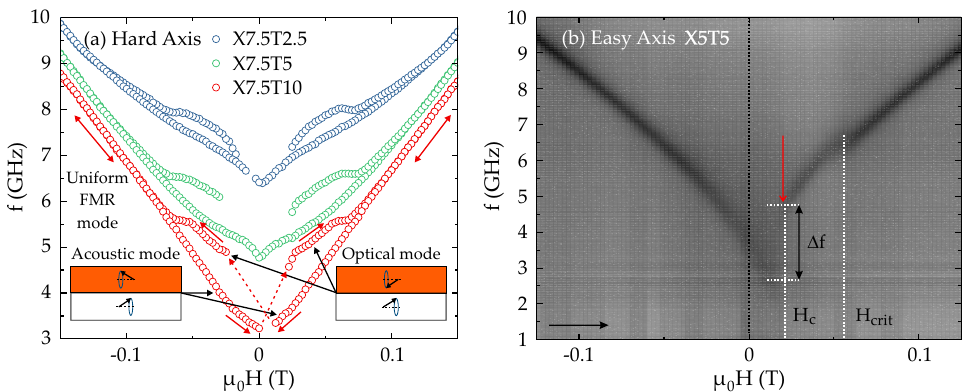
Figure 8. ( a ) Hard axis data of the X7.5 series. Red arrows indicate the field sweep directions with respect to the FMR line hysteresis around zero-field. The suggested modes corresponding to the different field regions of the f – H characteristic are also shown. ( b ) Easy axis frequency–field characteristic of the X5T5 sample for the up-sweep field direction. Critical and coercive fields are also